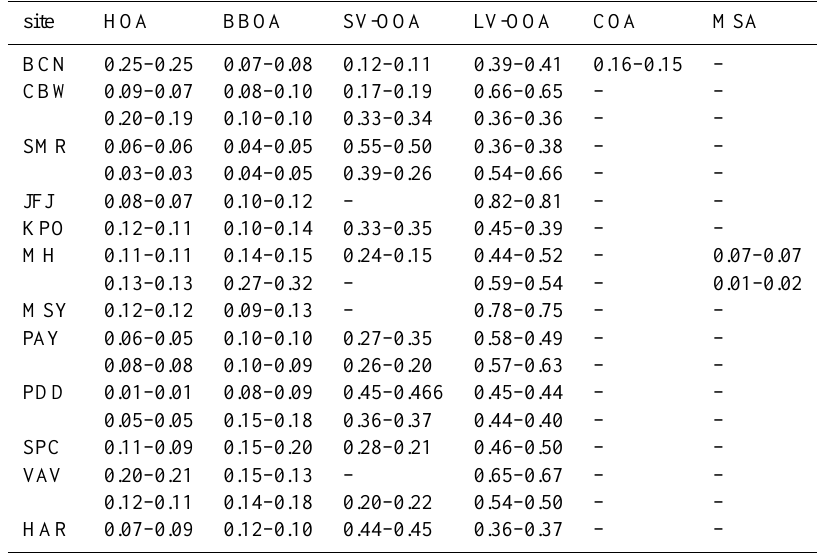
Table 4. Sensitivity analysis for the BBOA factor ( a value range = 0.2-0.4, a value for HOA = 0.05). The relative contribution of OA sources to the total OA is reported varying the BBOA a value. In the table, the first number refers to the solution obtained with an a value of 0.2 and the second one to with a value of